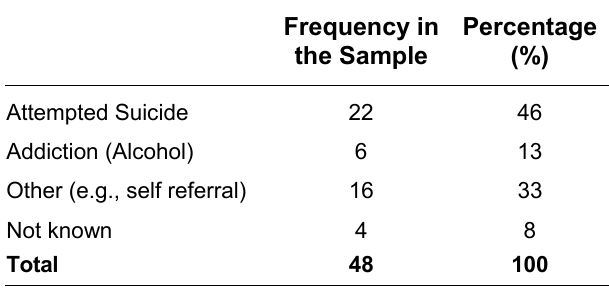
Method of Coming into Contact with Psychiatric Services Frequency